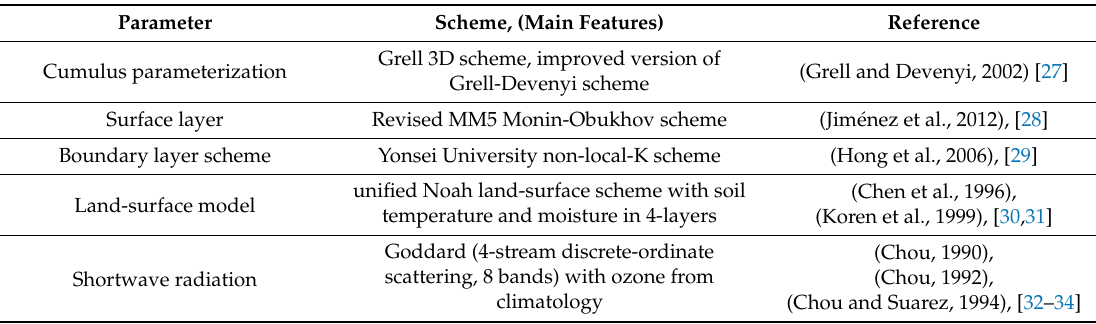
Table 1. The parameterizations of the WRF-ARW meteorological model used in this